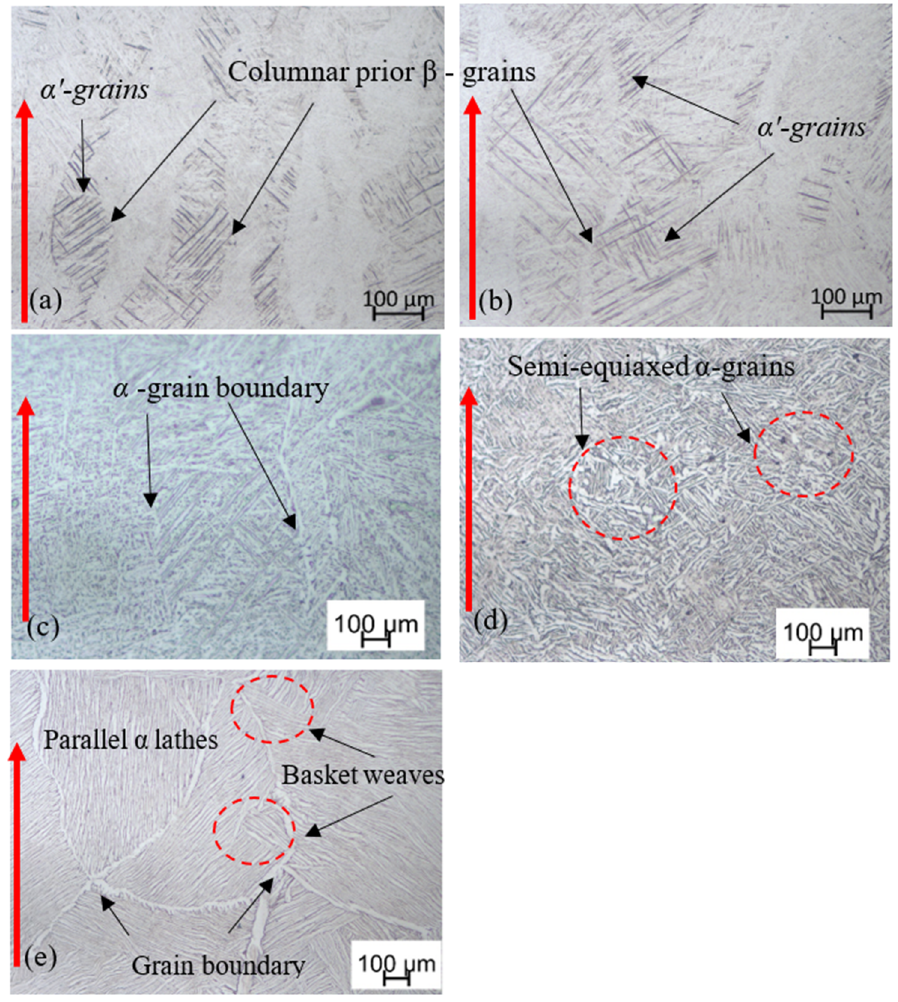
Figure 3. Optical images of ( a ) nonheat-treated samples A and heat-treated samples ( b ) B, ( c ) C, ( d ) D and ( e ) E of DMLS Ti6Al4V (ELI). The red arrows indicate the build direction.